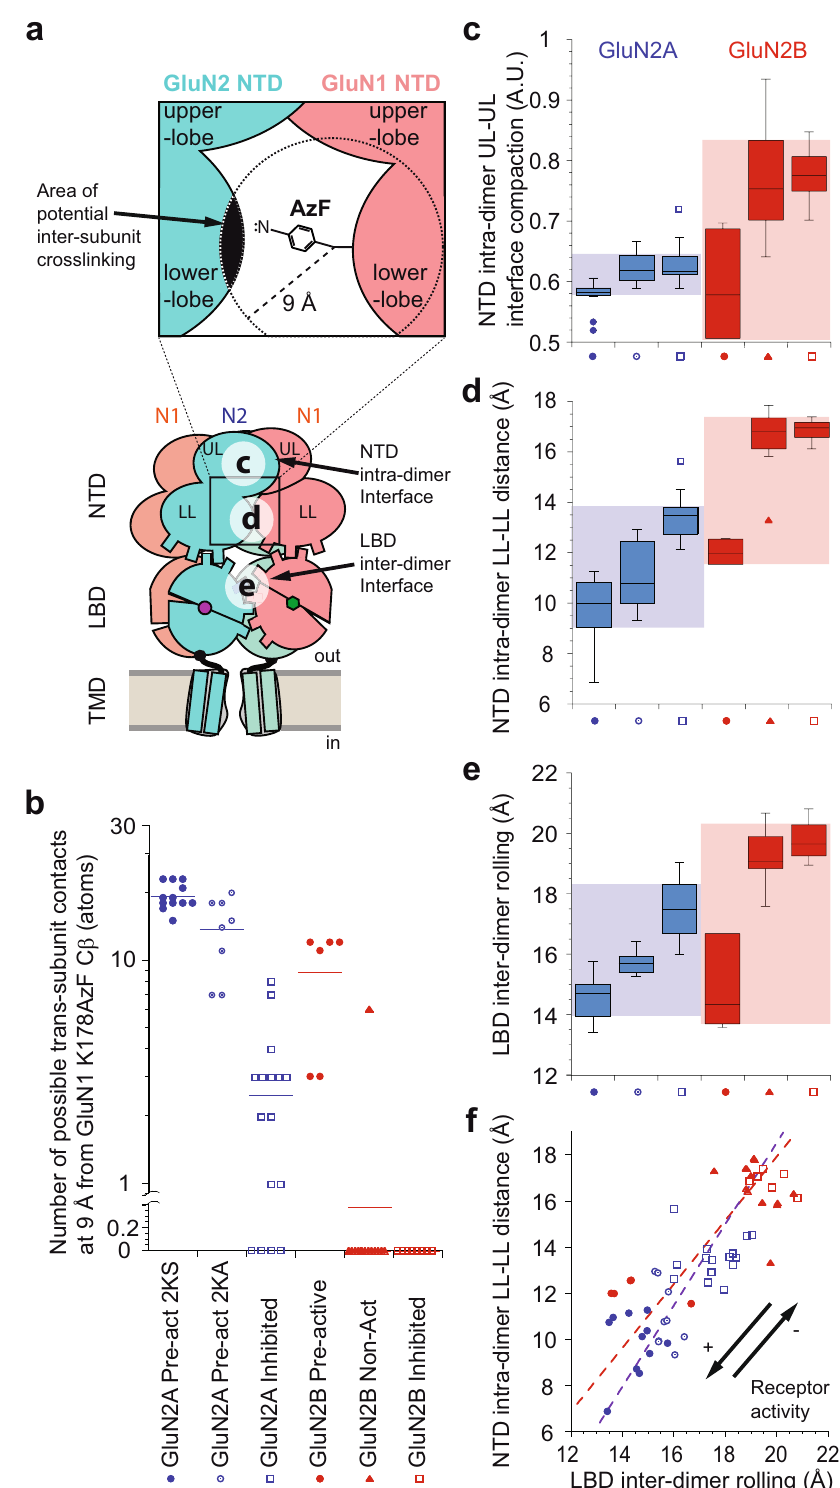
states) volumes. Similarly, distance measurements between the GluN1 and GluN2 NTD lower lobes show that GluN2B receptors can sample much greater separation than GluN2A receptors (Fig. 6d). Hence, individual NTD heterodimers are more compact and tightly packed in GluN2A than GluN2B receptors. This stable compactness of NTD heterodimers in GluN2A receptors likely accounts for their poor sensitivity to conformational